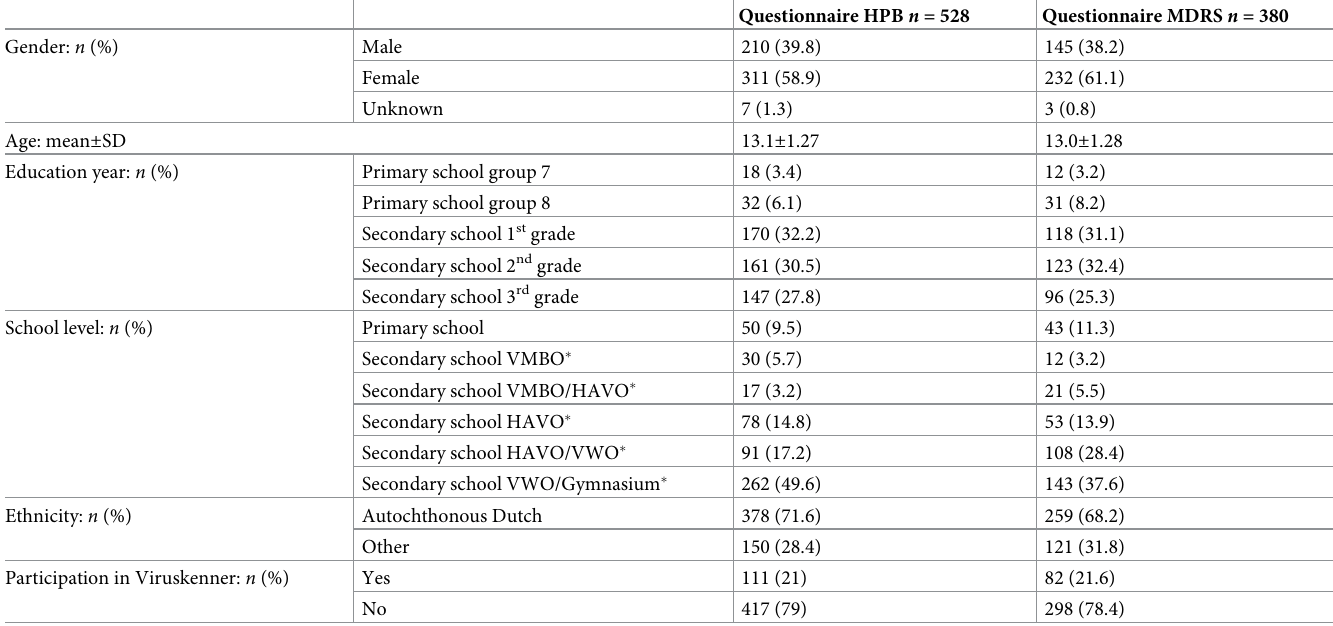
Table 1. Baseline characteristics of the participants.